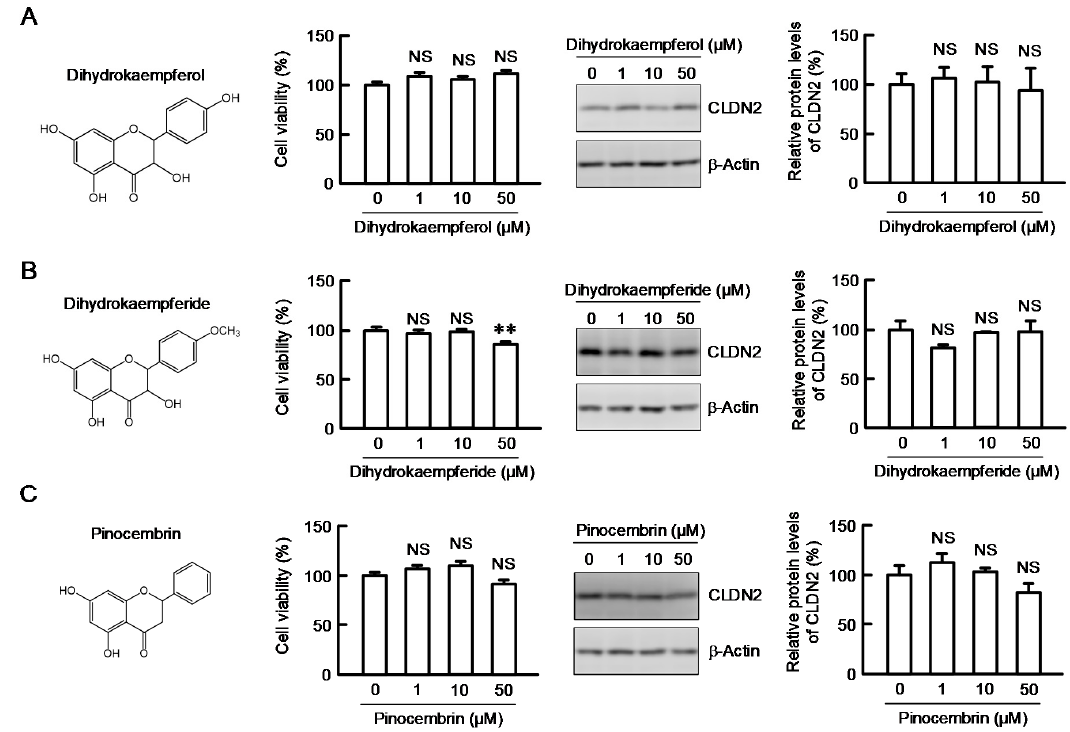
Figure 5. E ff ects of dihydrokaempferide derivatives on viability and CLDN2 expression. Cells were incubated with 0, 1, 10, and 50 µ M dihydrokaempferol ( A ), dihydrokaempferide ( B ), or pinocembrin ( C ) for 24 h. The structures of these derivatives are shown in the left. Cell viability was assessed by WST-1 assay and represented as a percentage relative to 0 μ M. The protein level of CLDN2 was examined by Western blotting and represented as a percentage relative to 0 μ M. n = 3–8. ** p < 0.01 and NS p > 0.05 compared with 0 µ M (One-way analysis). Viability in dihydrokaempferol (F 6,11 = 4.72, p = 0.02357), viability in dihydrokaempferide (F 6,16 = 17.65, p < 0.0001), viability in pinocembrin (F 6,11 =